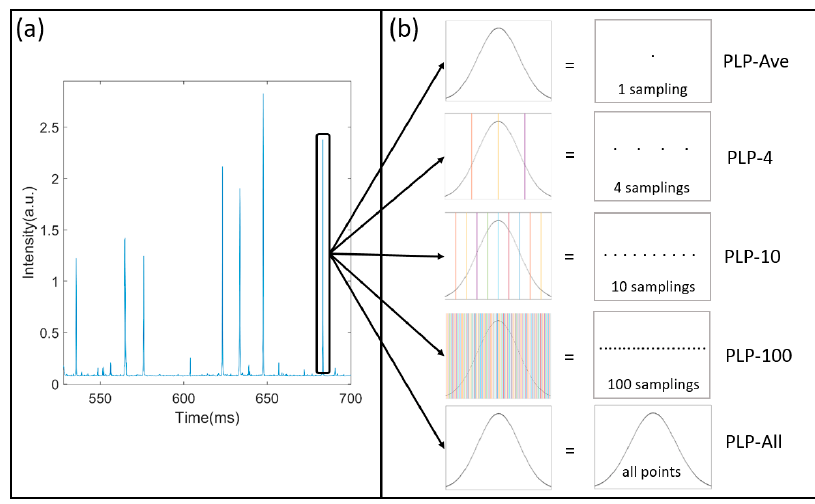
Figure 2. The dense sampling of polarized light pulses: ( a ) The temporal signals; ( b ) polarized light pulse processing algorithm.